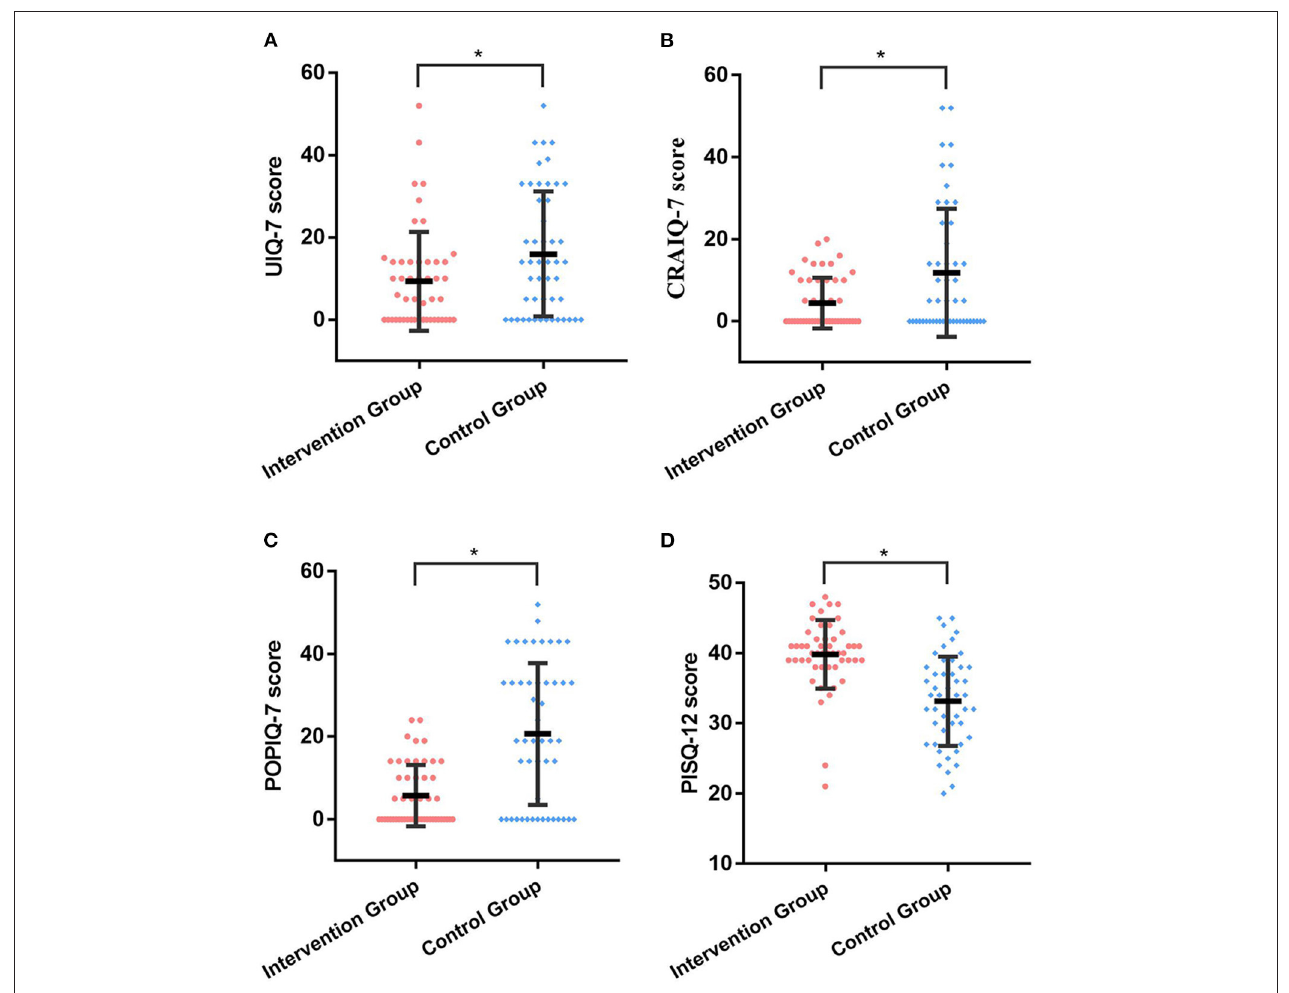
FIGURE 3 | The quality of life for patients at 6-month follow-up. (A) The postoperative UIQ-7 scores in intervention group and control group. (B) The postoperative CRAIQ-7 scores in intervention group and control group. (C) The postoperative POPIQ-7 scores in intervention group and control group. (D) The postoperative PISQ-12 scores in intervention group and control group. *, p <